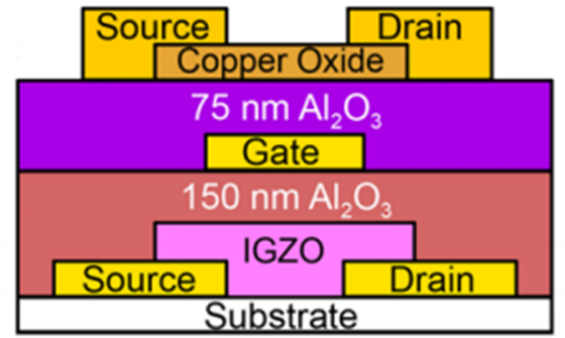
Figure 16: Schematic of a vertically stacked p-type CuO x TFT fabri- cated on top of an n-type IGZO TFT on a flexible PES substrate